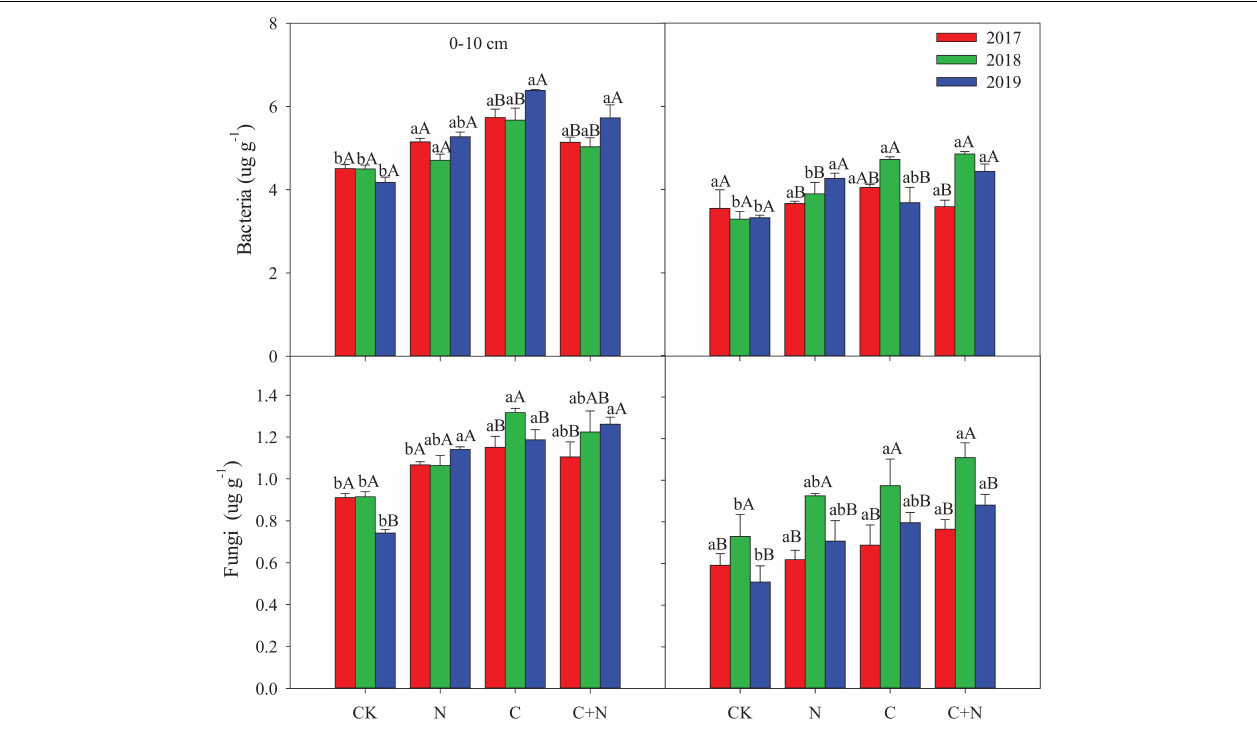
FIGURE 3 | Effects of different treatments on microbial biomass in 0–20 cm soil layers in 2017, 2018, and 2019. Error bars represent standard errors of the mean values, and different lowercase letters over the bars indicate differences among different treatments in the same year at P < 0.05. Different uppercase letters over the bars indicate differences among different years in the same treatment at P <